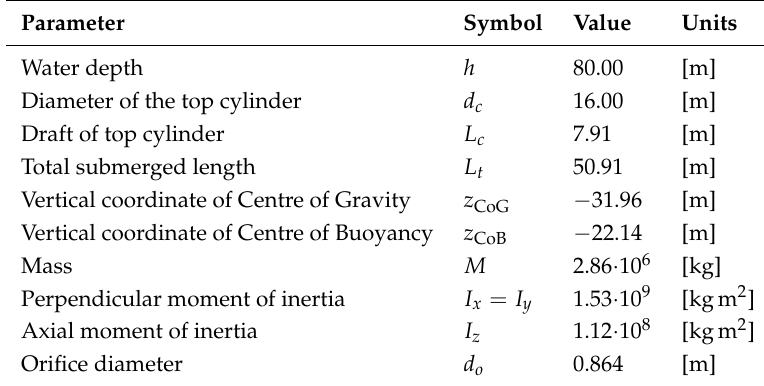
Table 1. Physical properties of the spar-buoy oscillating water column (OWC) device shown in Figure 1, in